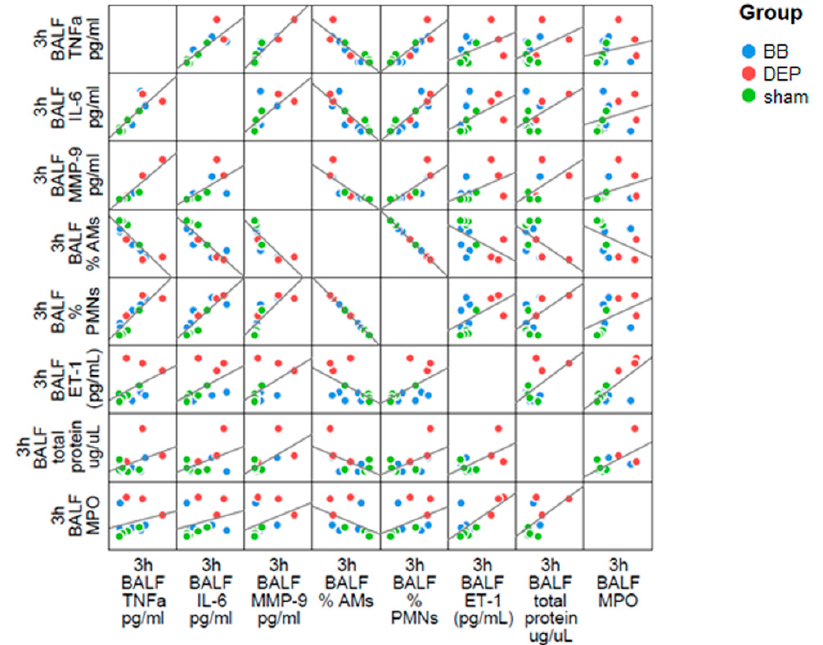
Figure 3. Correlation analysis in BALf. Dispersion plot showing the co-distribution of BALf parameters in acute treatment. Linear regression correlations are displayed as black lines.